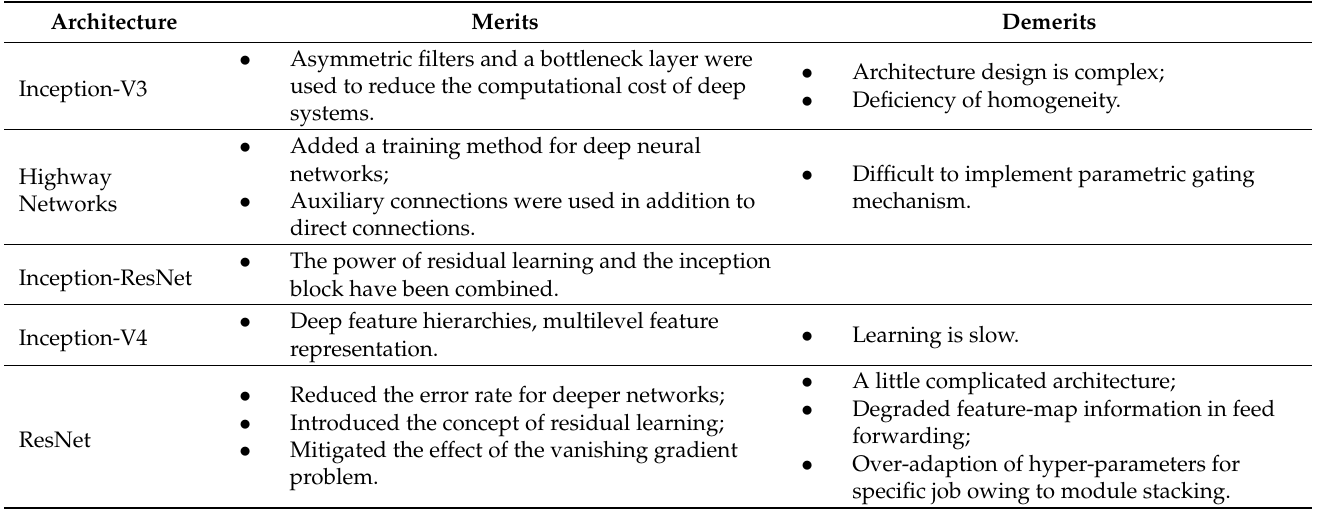
Table 3. Major issues linked with the deployment of depth-based CNN